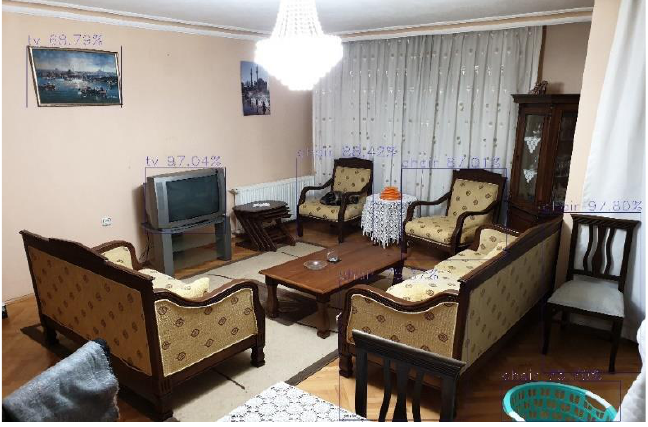
Fig. 17. Objects recognized with RetinaNet architecture in the living room.